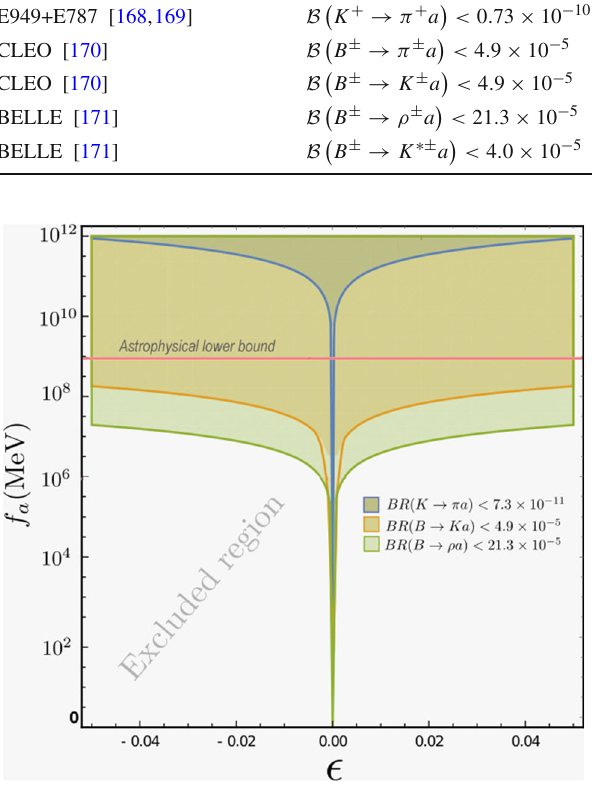
Fig. 2 Allowed regions for semileptonic meson decays. We use the relation (1) between the axion mass and the decay constant f a